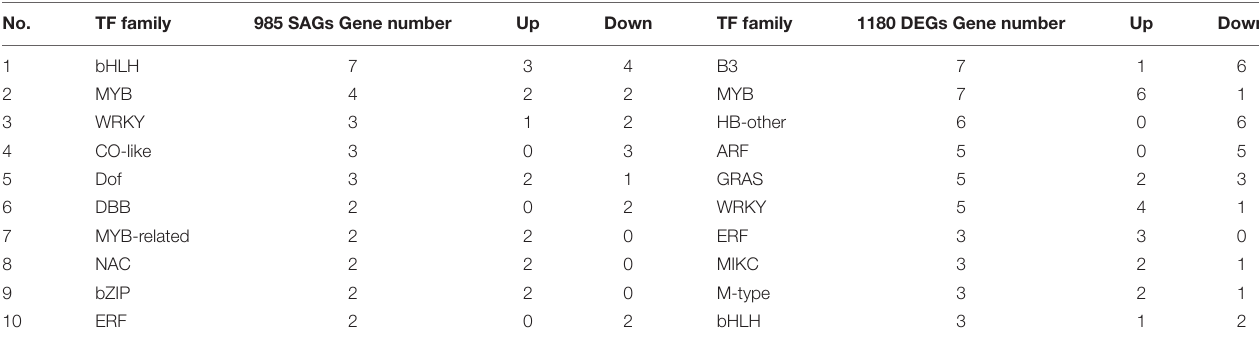
TABLE 2 | Transcription factors (TFs) predicted from 985 SAGs and 1,180 DEGs ( Figure 3B ).